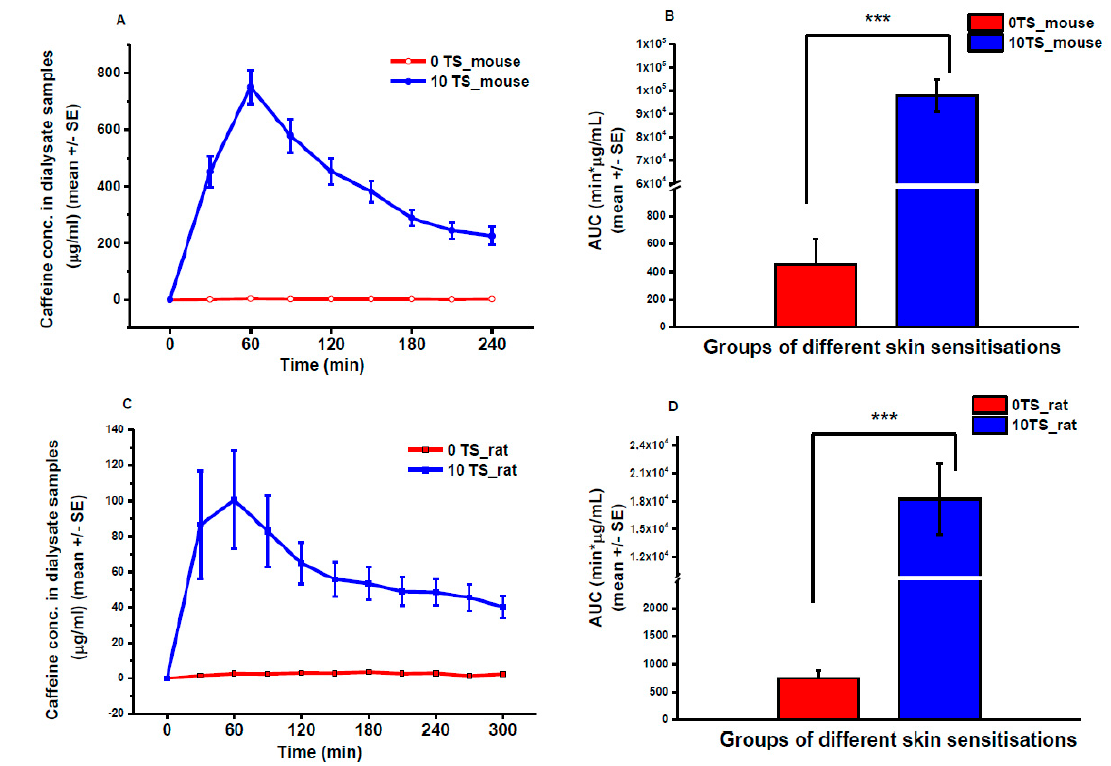
Figure 7. Caffeine absorption in vivo in anesthetized rodents measured by transdermal microdialysis. Concentration-time profiles of caffeine skin penetration in mouse ( A ) and rat ( C ) abdominal skin surface. Area under the concentration-time curves (AUC) in mice ( B ) and in rats ( D ). 0 TS: native skin, without tape-stripping; 10 TS: sensitized skin, with 10 tape-strippings. N = 5, ***: p < 0.005 in two-sample student t -test.